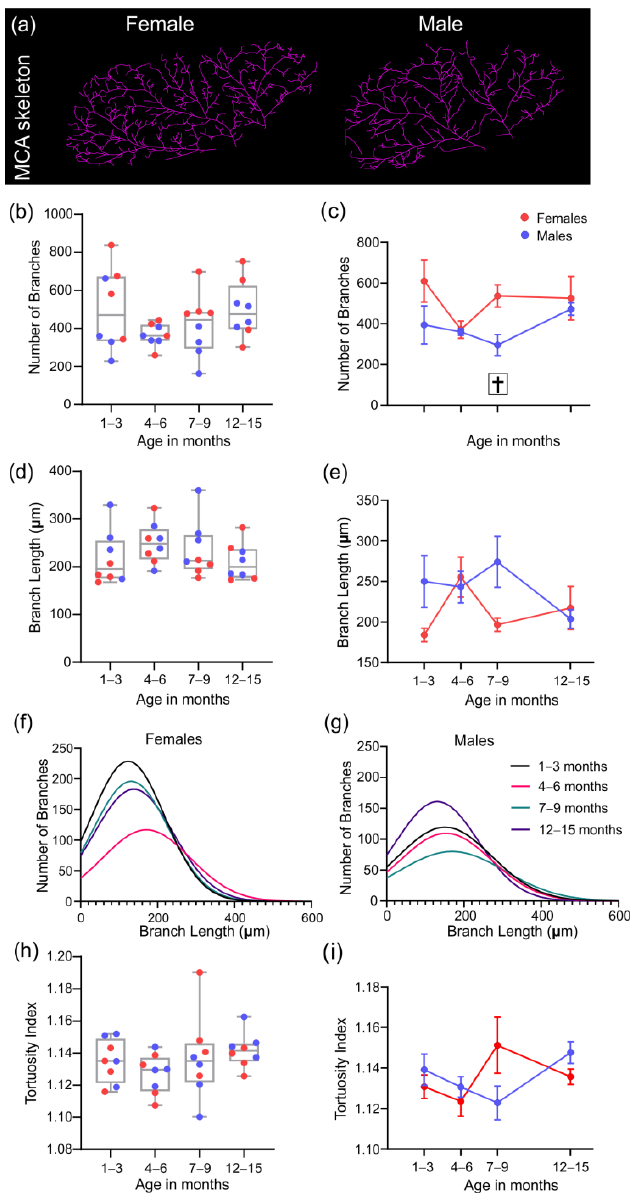
Figure 7. MCA skeleton derived analytic features. Representative images illustrating the MCA skeleton for female and male 3xTg-AD mice at 7 – 9 months of age ( a ). Total number of MCA branches was not statistically different between age groups ( b ) nor for males and females ( c ). Similarly, there are no differences in average MCA branch length across age groups ( d ) or by sex ( e ). The distribution of the branch length is represented for females ( f ) and males ( g ). The average tortuosity index of the MCA branches is shown for all age groups ( h ) and separated by sex ( i ). † indicates a significant effect of sex, with † p < 0.05. Data shown in ( c , e , i ) as mean ± SEM. Note that comparisons among males versus females at the 7 – 9 month timepoint are indicated by p = 0.088, p = 0.084, and p = 0.062 for panels c , e , and i , respectively.